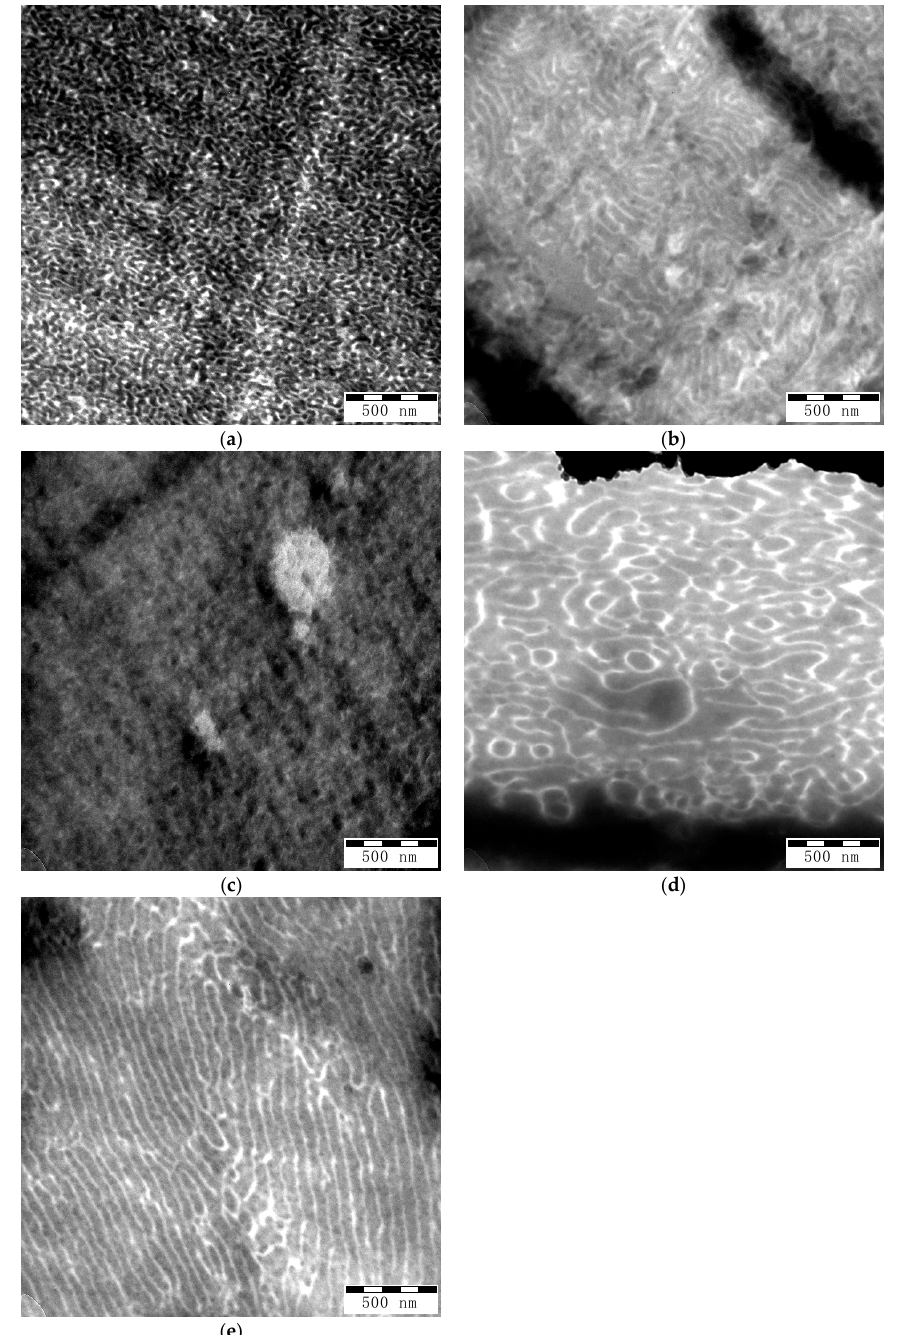
Figure 7. TEM pictures of copolymer blends at magnification of 40,000×. ( a ) G-B GMA (52-4); ( b ) G-B GMA (104-4.1); ( c ) G-B GA (55-4.7); ( d ) G-B GA (98-4); ( e ) G-B GA (98-9.8).The reduced domain sizes in G-B GMA (52-4), G-B GMA (104-4.1), and G-B GA (55-4.7) correlate well with the mechanical characteristics of